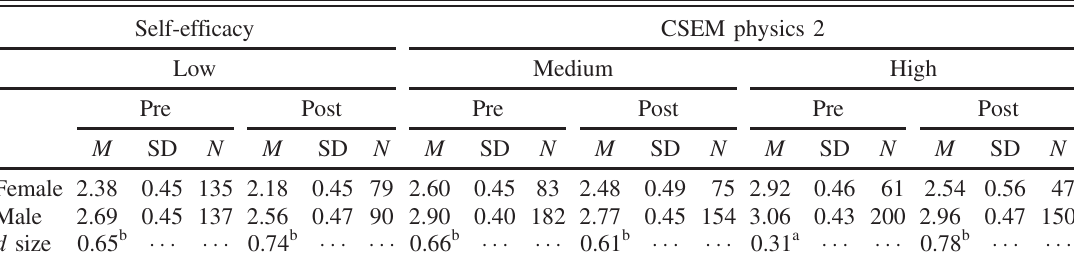
TABLE VI. Self-efficacy scores in physics 2 binned by CSEM scores (high, medium, low) for female and male students ( M ¼ mean, SD ¼ standard deviation, N ¼ number of students), along with Cohen ’ s d for the gender contrast in means.